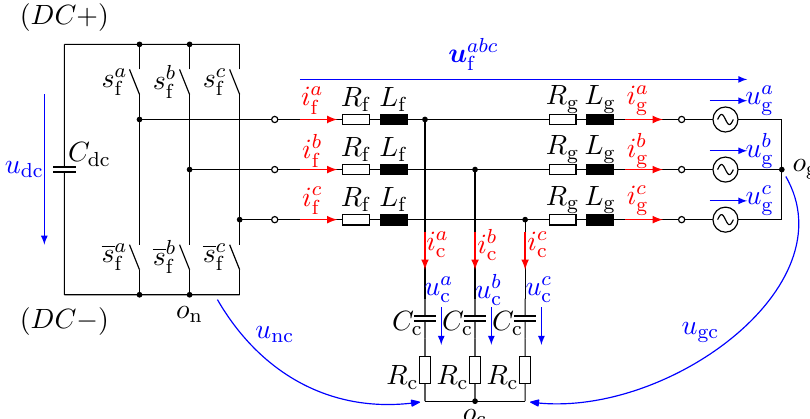
Figure 1. Considered system consisting of the dc-link capacitor C dc , GCI with six active switches, LCL filter and grid (figure based on